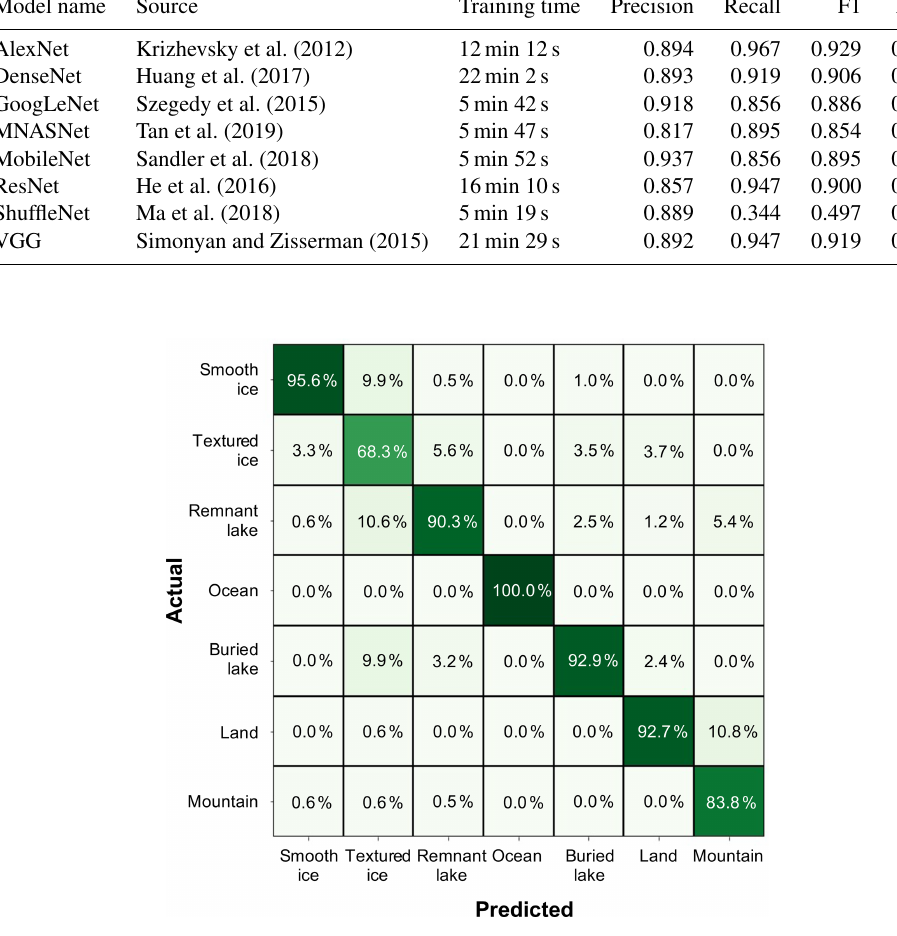
Figure A1. CNN test dataset confusion matrix. Values are normalized by the predicted conditions and thus represent the precision for each class. For example, a value of 92.9% for predicted shows a buried lake and actual show a buried lake, meaning that 92.9% of the predicted buried lakes are actually buried